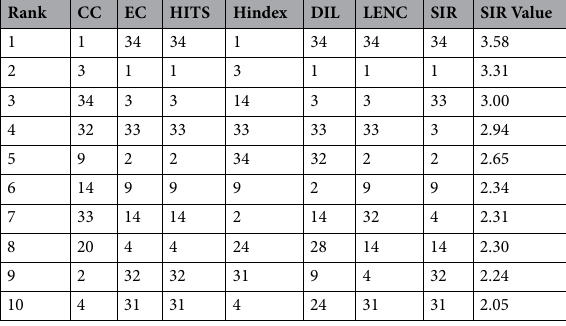
Table 4. Comparison of ranking results of top-10 nodes in karate network.